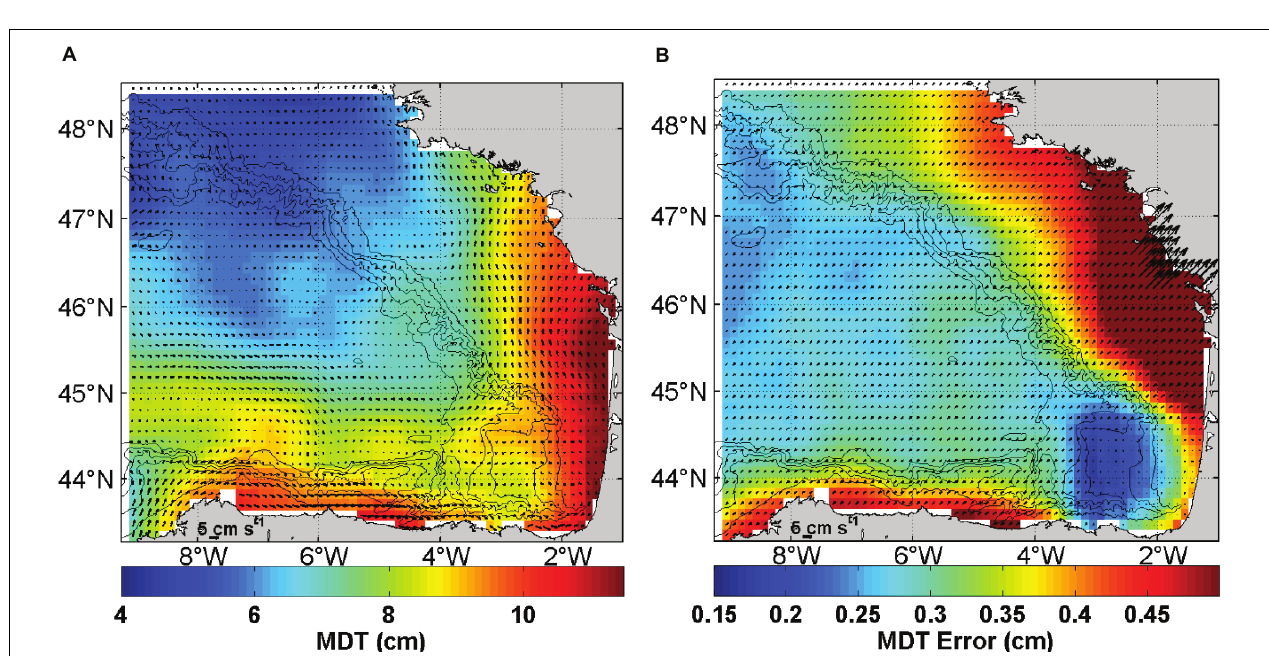
FIGURE 8 | Coastal MDT (cm) (A) and associated error (cm) (B)